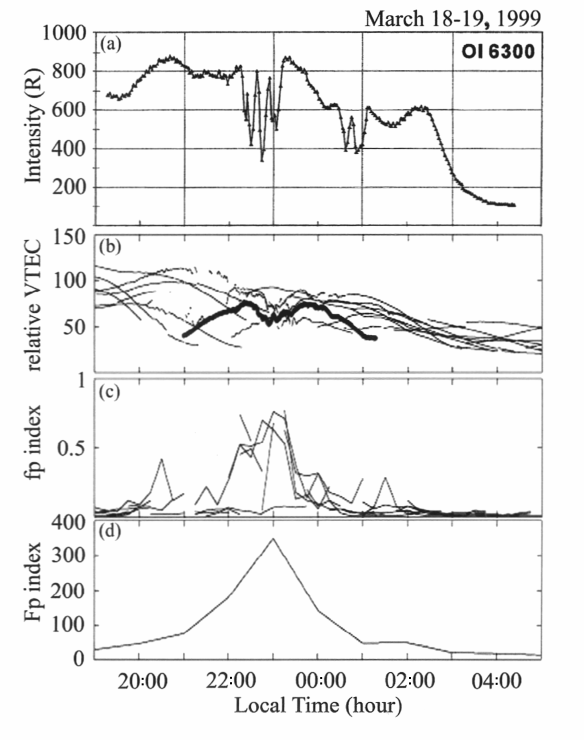
Fig. 2. The nocturnal ionospheric phenomena recorded with a pho- tometer and a GPS receiver on 18 March 1999. (a) Intensity vari- ations of OI6300 F-region component observed by a zenith pho- tometer over Cachoeira Paulista. After Takahashi et al. (2001). (b) Relative vertical TEC derived from GPS at Brasilia, (c) 15-min fp index, and (d) hourly Fp